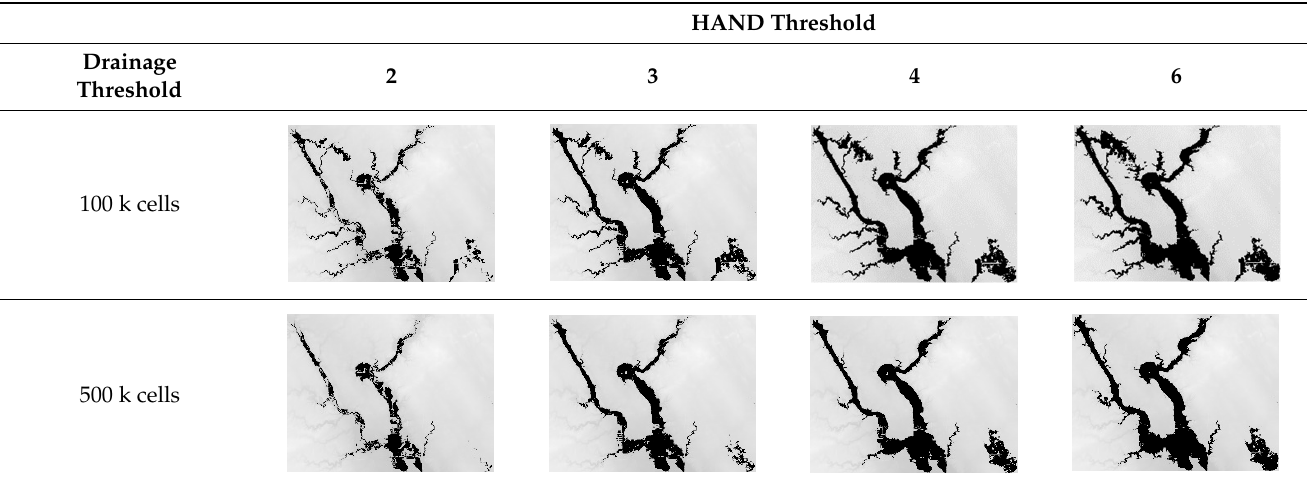
Table 1. Sensitivity of model parameters (HAND threshold, drainage threshold) on the resulting flood extent (absolute threshold 220 ft).